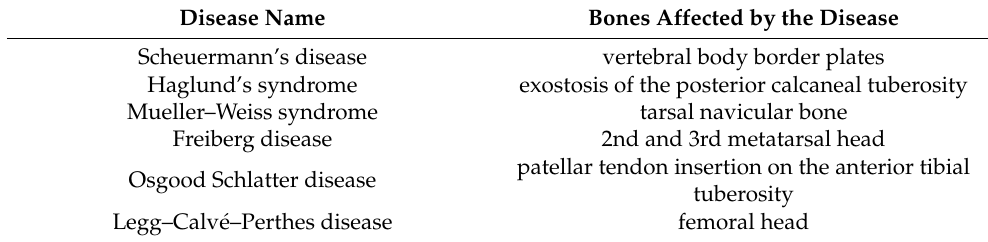
Table 1. The most common types of bone necrosis